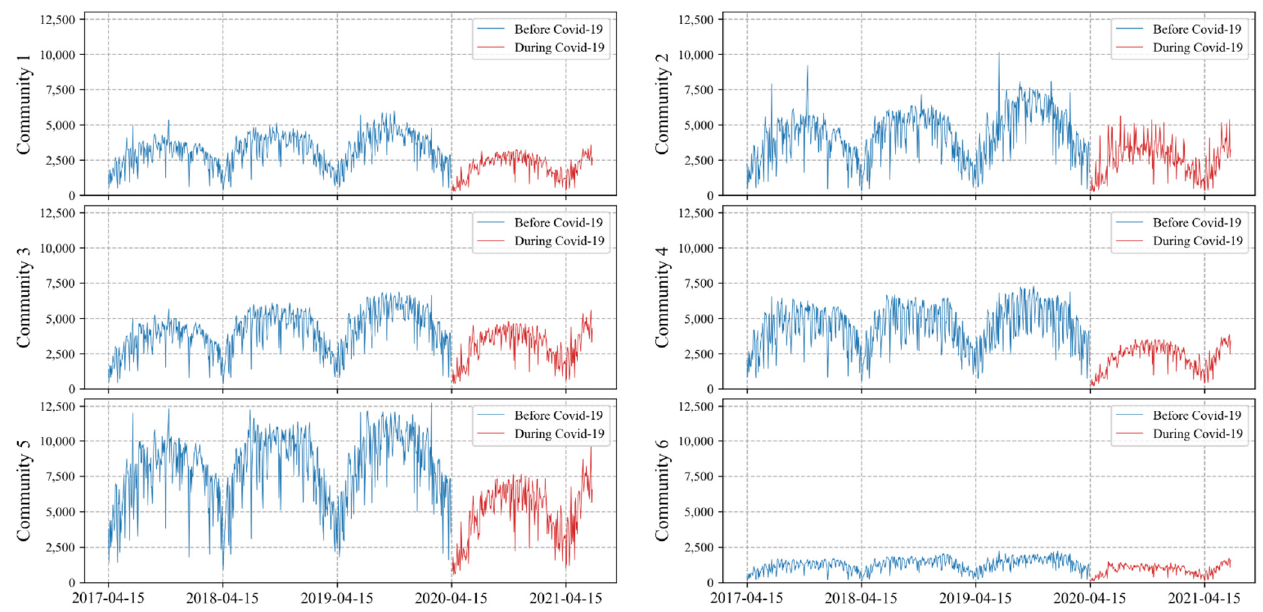
Figure 5. Daily pickups for different BIXI communities over